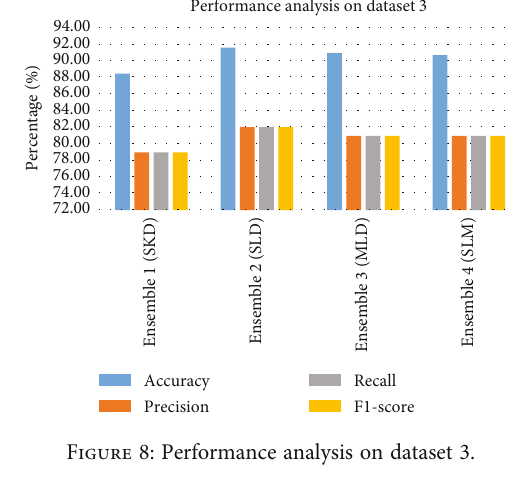
Figure 8: Performance analysis on dataset 3.